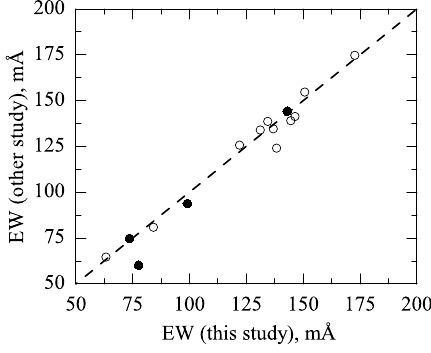
Fig. 2. Comparison of the equivalent widths of Fe I ( ◦ ) and Fe II ( • ) lines in HD 209621 measured in this study and by Goswami & Aoki (2010).